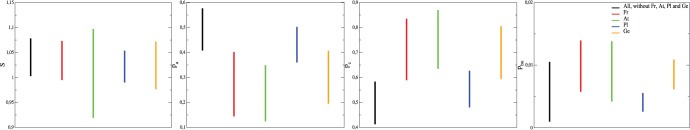
Minimal intervals containing  of events, of the involvement entropy  and ratios ,  and  of the 100 most populated municipalities over all elections since 2000.See Fig. 8-d for the related histograms.